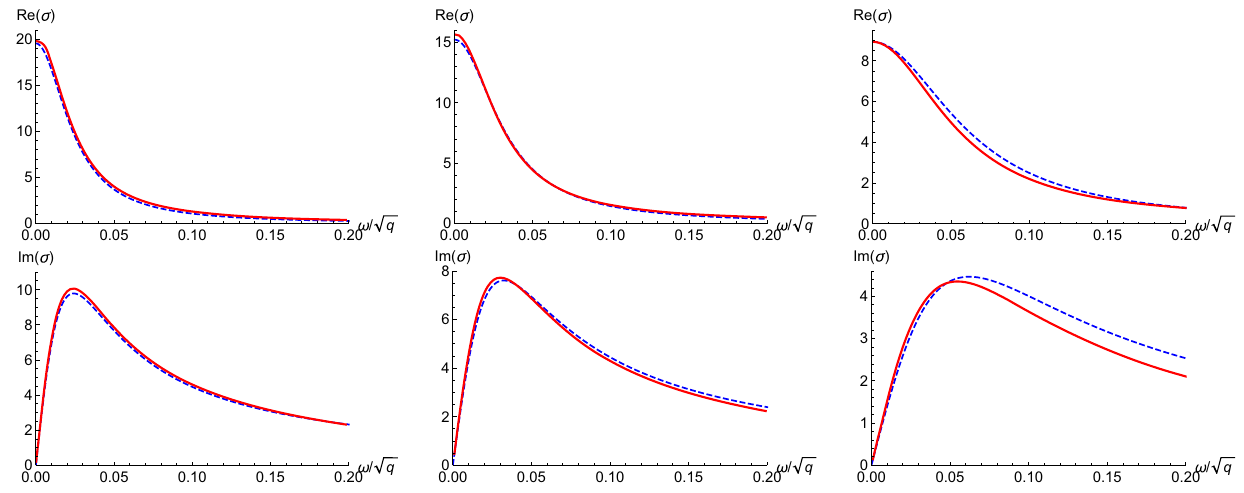
Fig. 7 The real (top) and imaginary (bottom) parts of the AC conductivity for different γ ’s. Left: γ = 1 / 3 . 05; Center: γ = 1 / 4; Right: γ = 0. Red solid lines are numerical solutions and blue dashed lines are results fitted by using Drude formula. Here, we have set T = 0 .